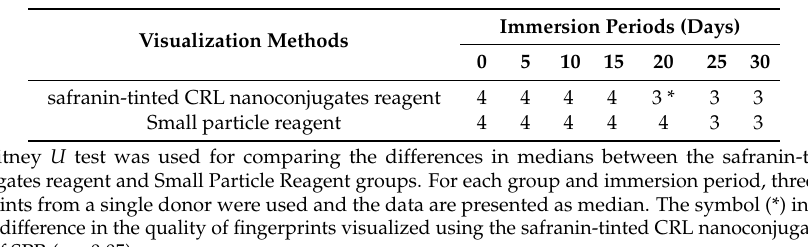
Table 1. The quality of visualized fingerprints on stainless steel knives immersed in a natural outdoor pond over specific immersion periods using the modified-Centre for Applied Science and Technology grading scheme.